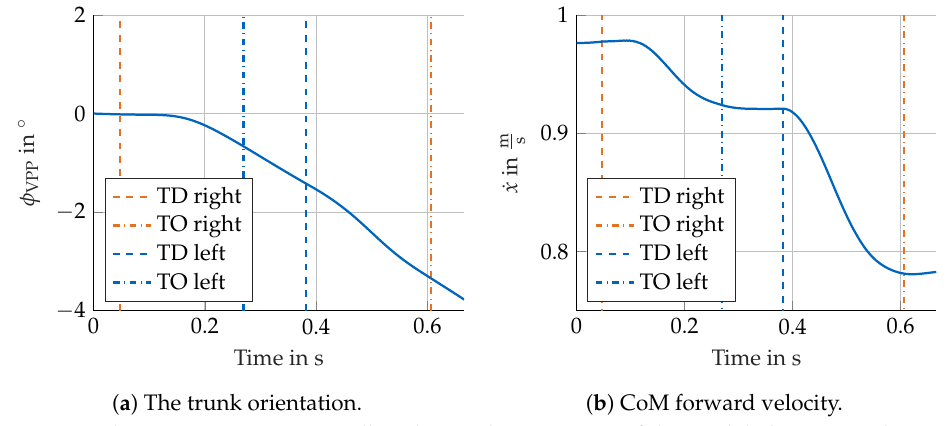
Figure 8. The CoM trajectory, as well as the trunk orientation of the modeled amputee during the HiL test of one